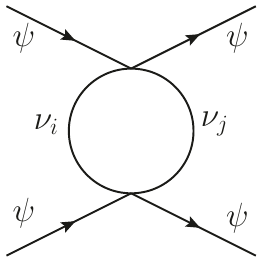
Figure 1 . The Majorana-Dirac confusion theorem. The blob represents an arbitrary SM amplitude from which we single out an internal neutrino propagator. Dirac mass insertions (top) and Majorana mass insertions (bottom) become negligible for p (cid:29) m (cid:23) such that amplitudes become equivalent in this limit.